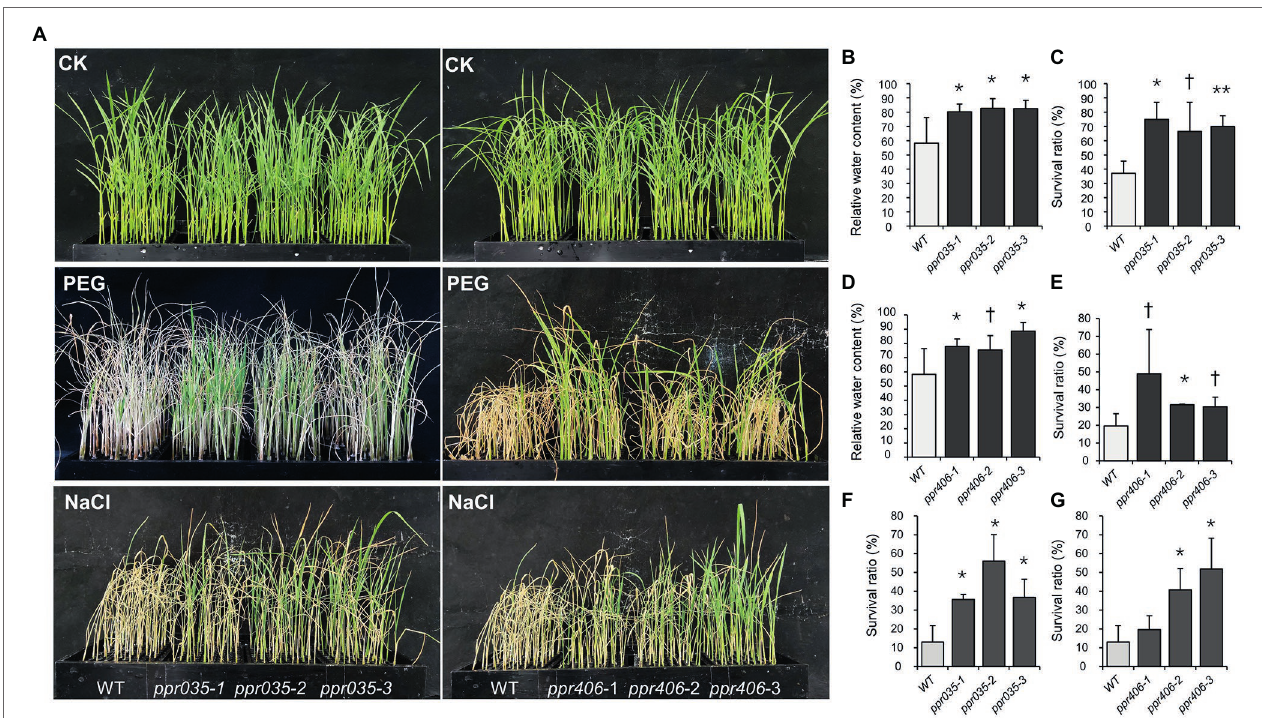
FIGURE 3 | Performance of the wild type (WT) and knockout mutants ( ppr035 -1/2/3 and ppr406 -1/2/3) under osmotic and salt stress. (A) Performance of plant materials in the treatments with normal nutrient solution (CK), 20% PEG6000, and180mM NaCl. (B,C) Relative water content and survival ratio of WT and ppr035 - 1/2/3 under osmotic stress. (D,E) Relative water content and survival ratio of WT and ppr406 -1/2/3 under osmotic stress. (F,G) Survival ratio of WT, ppr035 -1/2/3, and ppr406 -1/2/3 under salt stress. † , *, and ** indicate significances at p < 0.1, p < 0.05, and < 0.01 by independent t -test between WT and